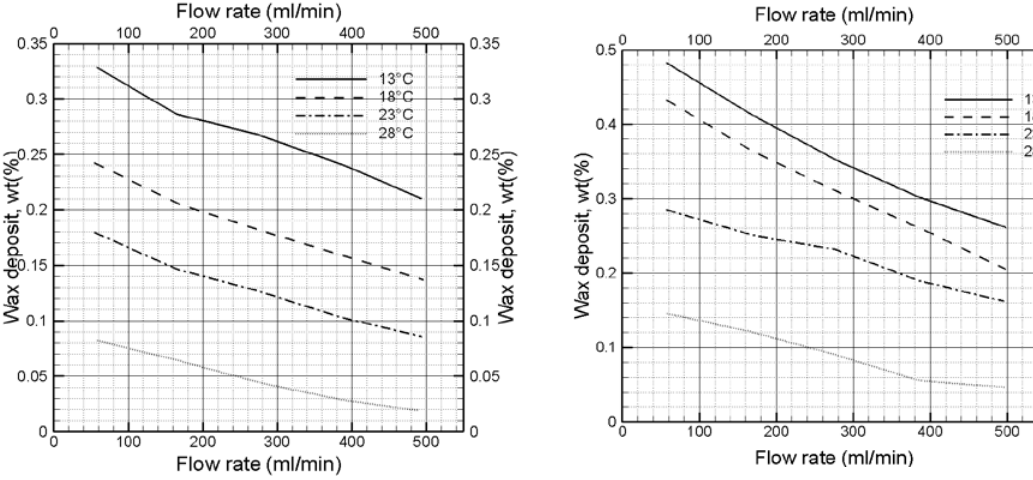
Figure 9 Effect of flow rate on deposited wax percentage at 3min (Kelechukwu et al., 2010)